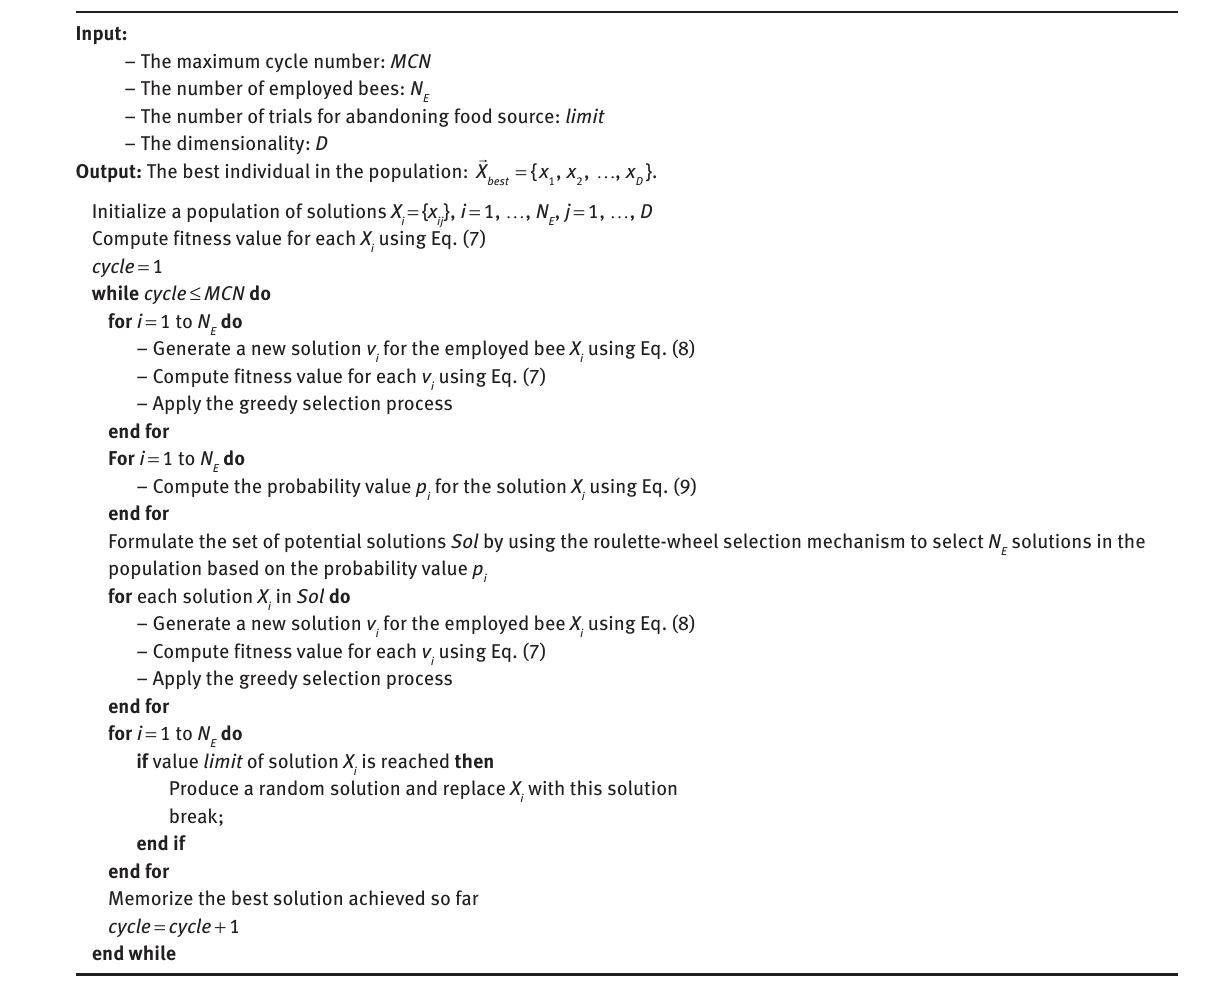
Algorithm 1: The Pseudo Code of the ABC